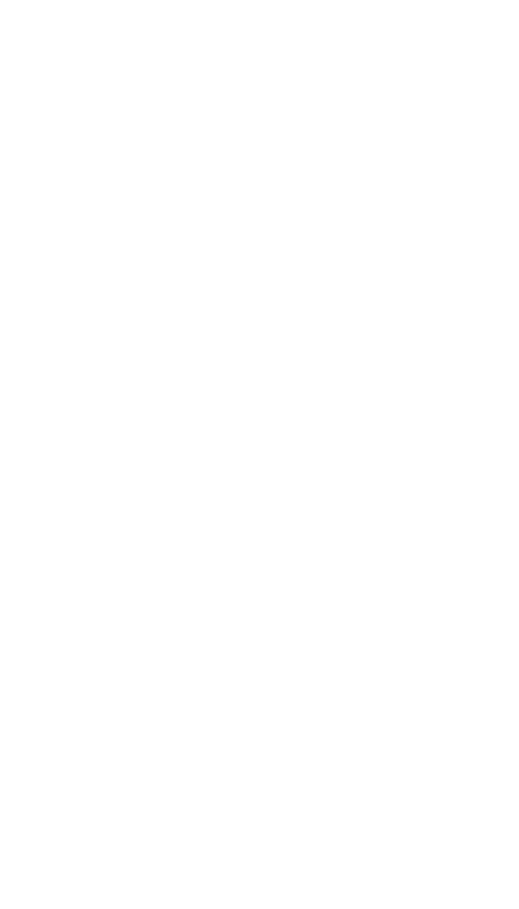
FIG. 1. Flowchart of the modified L929 cytotoxic bioassay system for TNF- a